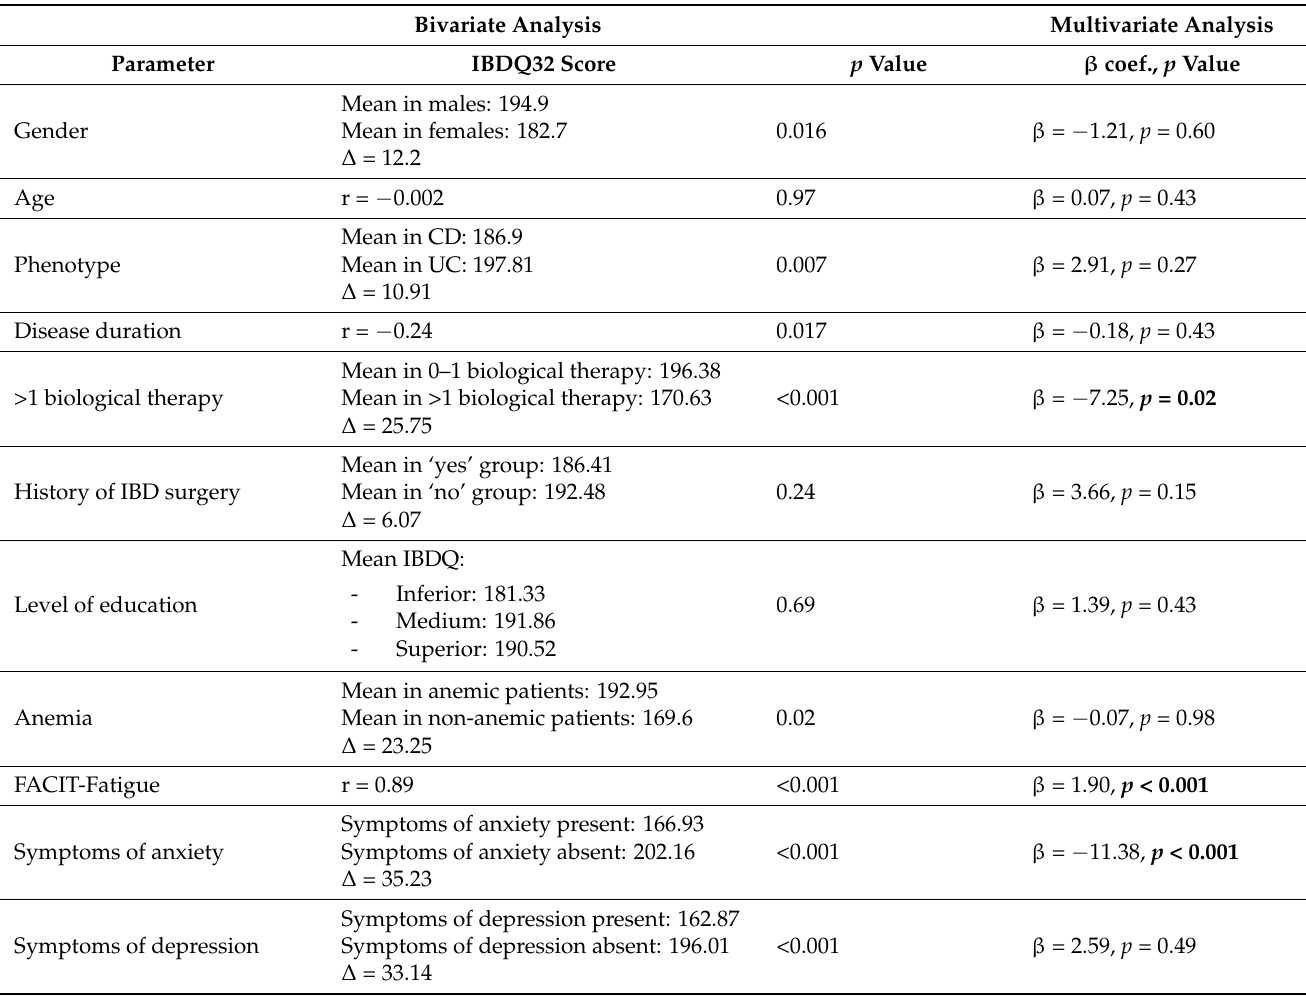
Table 2. Analysis of factors that altered the HR-QoL. Bivariate Analysis Multivariate